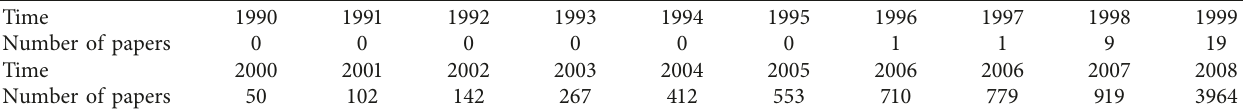
Table 9: The search outcomes of “rough